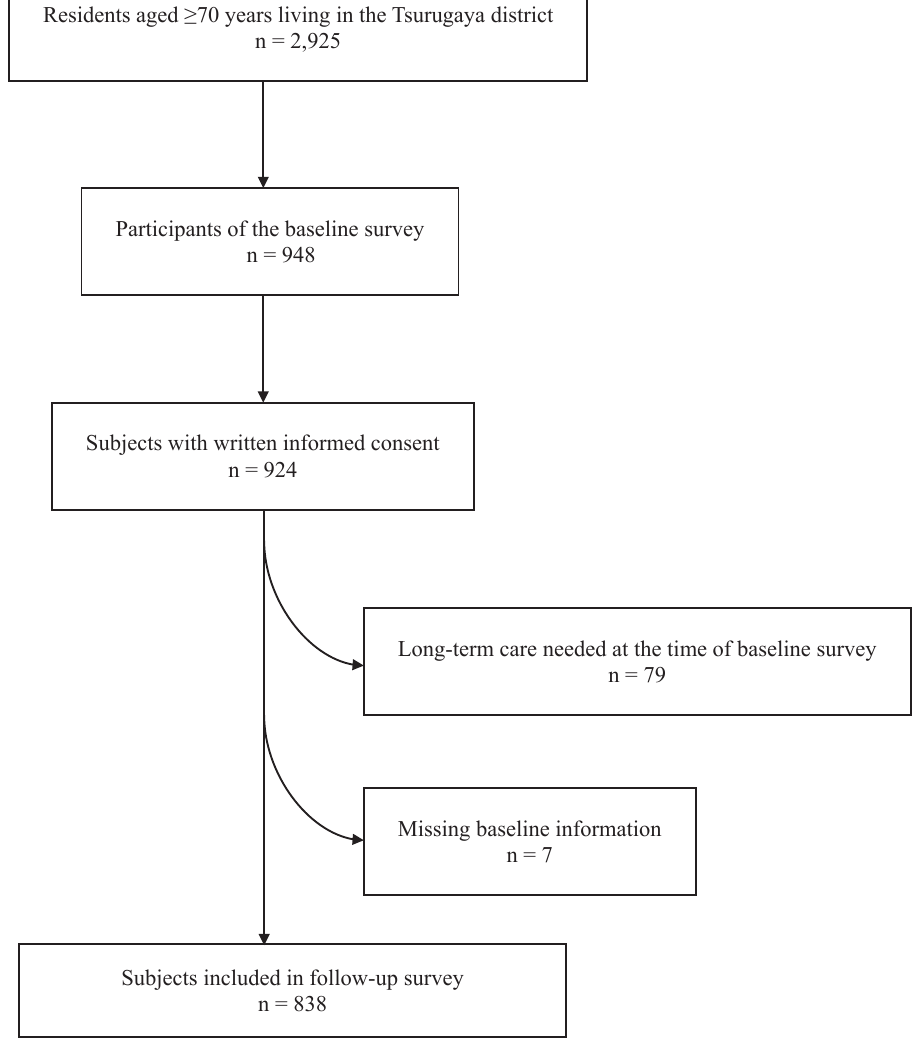
Figure 1. Flow diagram of study